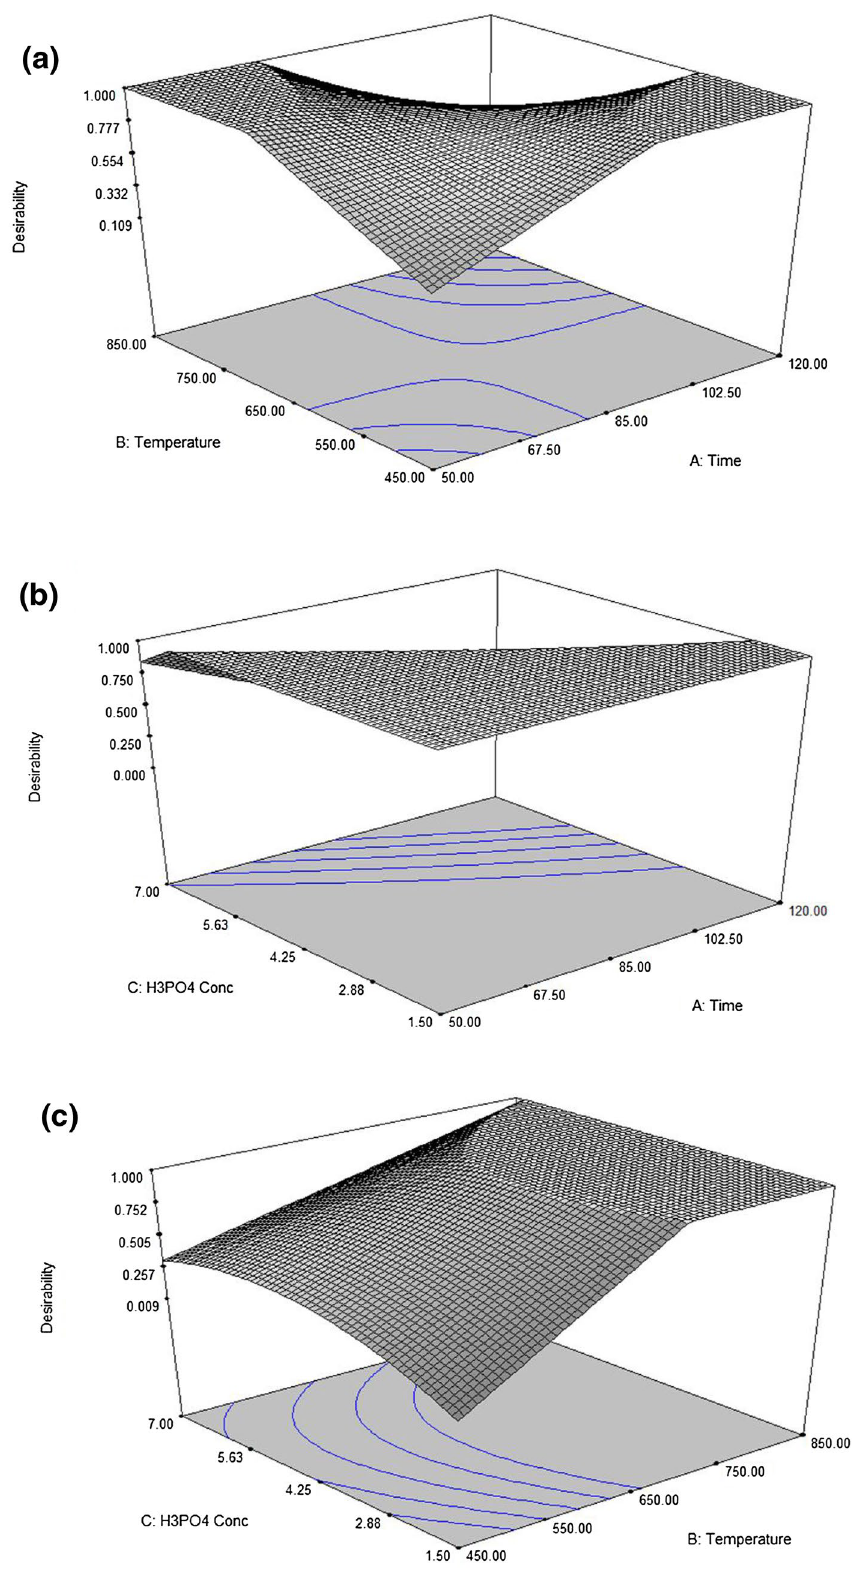
Fig. 3 Desirability plots for maximum adsorption capac- ity of banana trunk-activated